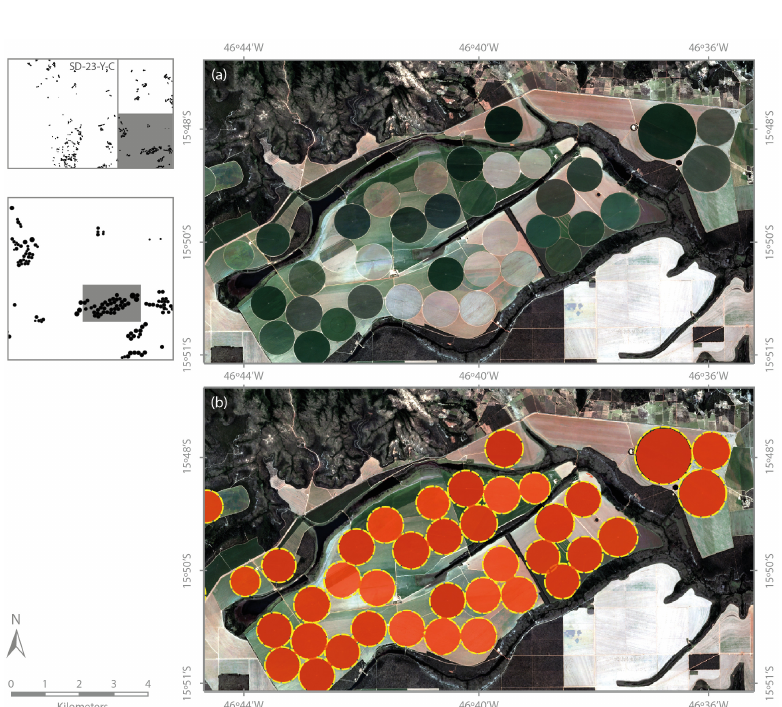
Figure 6. Results for an area of grid SD-23-Y-C-5 in the Brazilian Continuous Cartographic Base, located in the municipality of Unaí, in the estate of Minas Gerais. ( a ) PlanetScope median mosaic, in true color composition, built using images from the period of August 2017 to November 2018; ( b ) comparison between the reference (yellow dotted lines) and our results